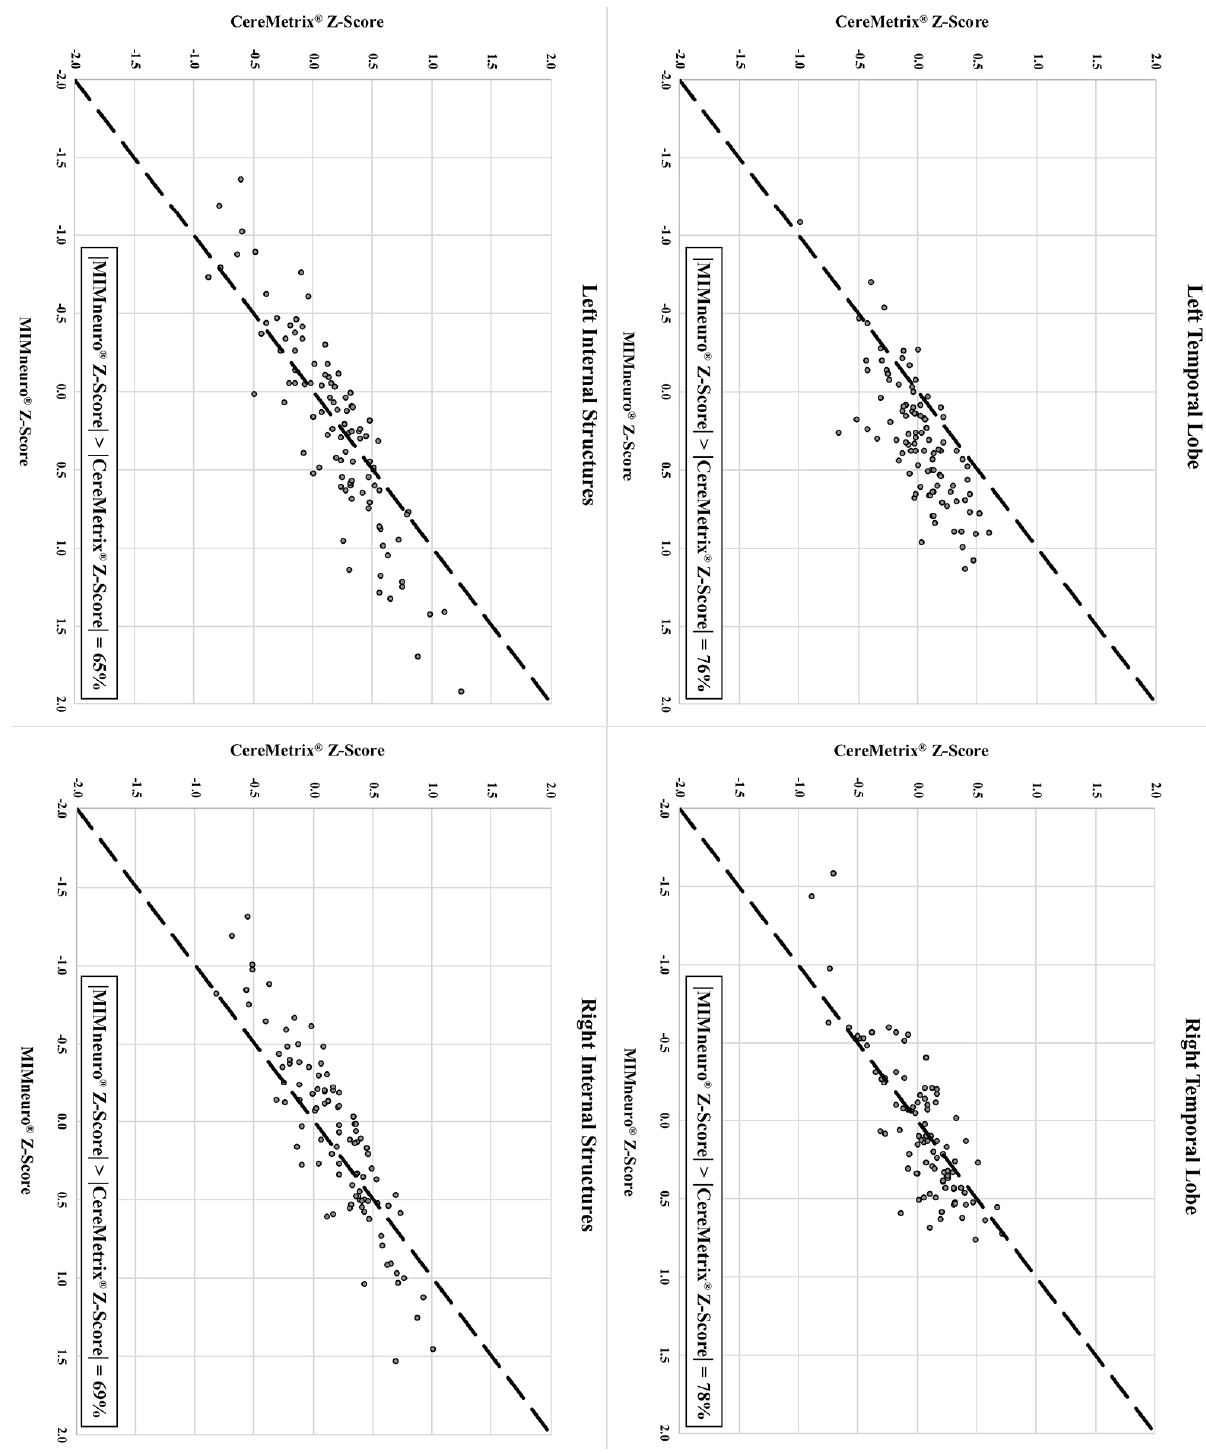
Figure 6. Temporal lobe and internal structures equality plots between CereMetrix ® and MIMneuro ® data showing their scatter around the line of equality. The proportion of measurements where MIMneuro ® ’s z-score magnitude was greater than the corresponding CereMetrix ® z-score magnitude is also